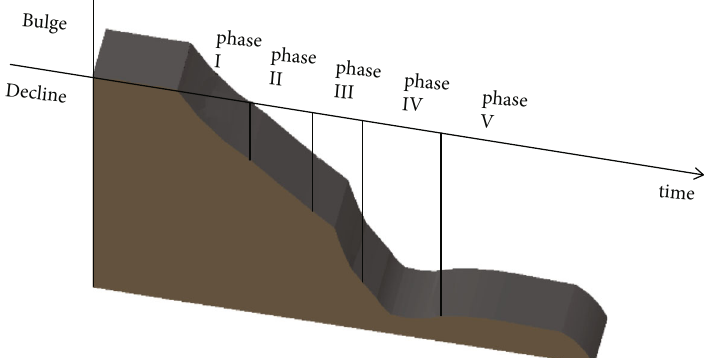
Figure 1: Time e ff ect characteristic curve.